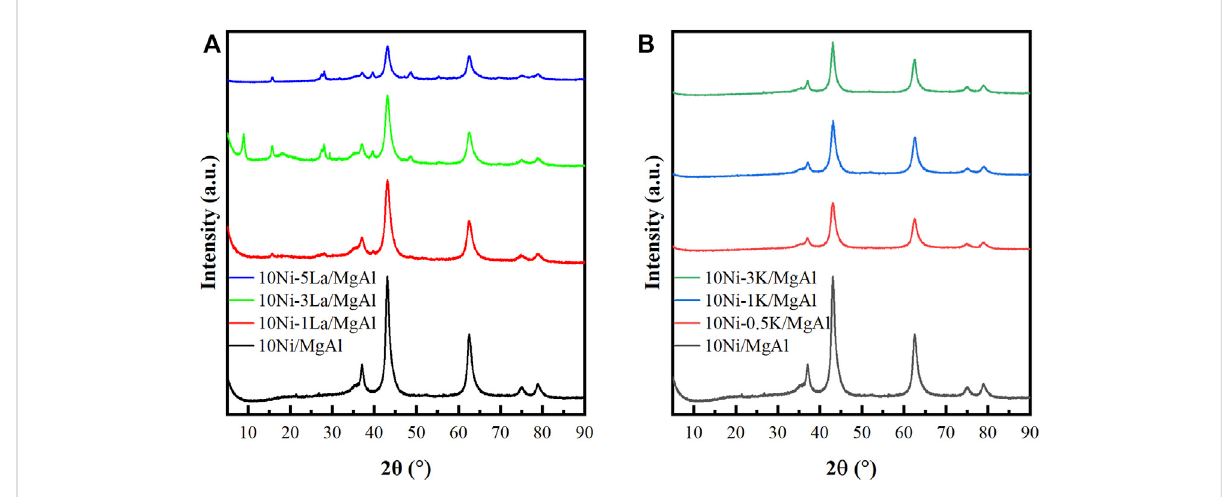
FIGURE 3 XRD patterns of reduced (A) La- and (B) K-modi fi ed